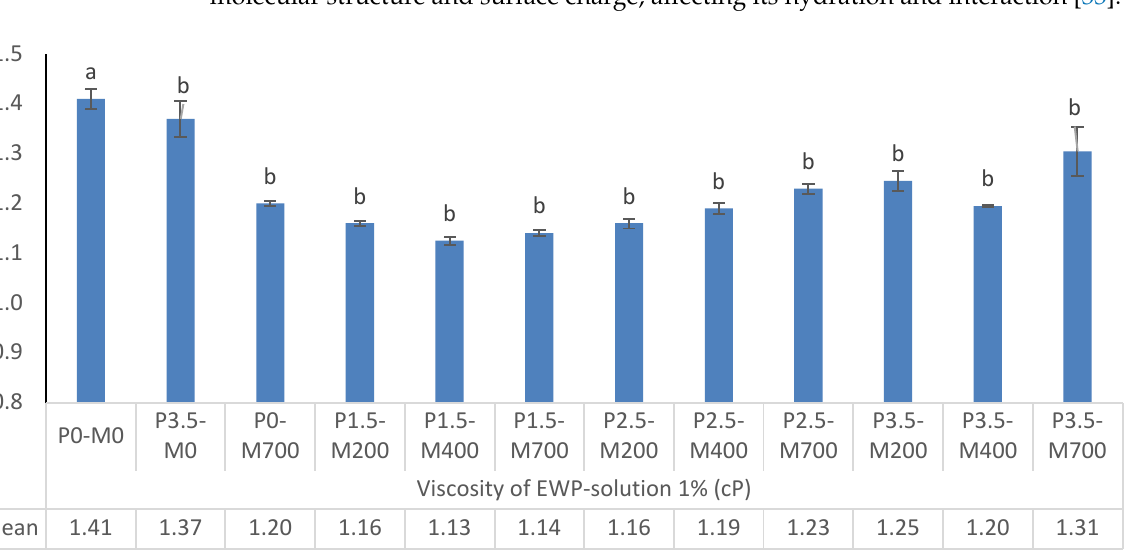
Figure 5. The effect of phosphorylation (%) and microwave power (W) on viscosity of egg white powder-solution 1%. Means ( n = 3) with different letters in each column indicate significant difference ( p < 0.05).